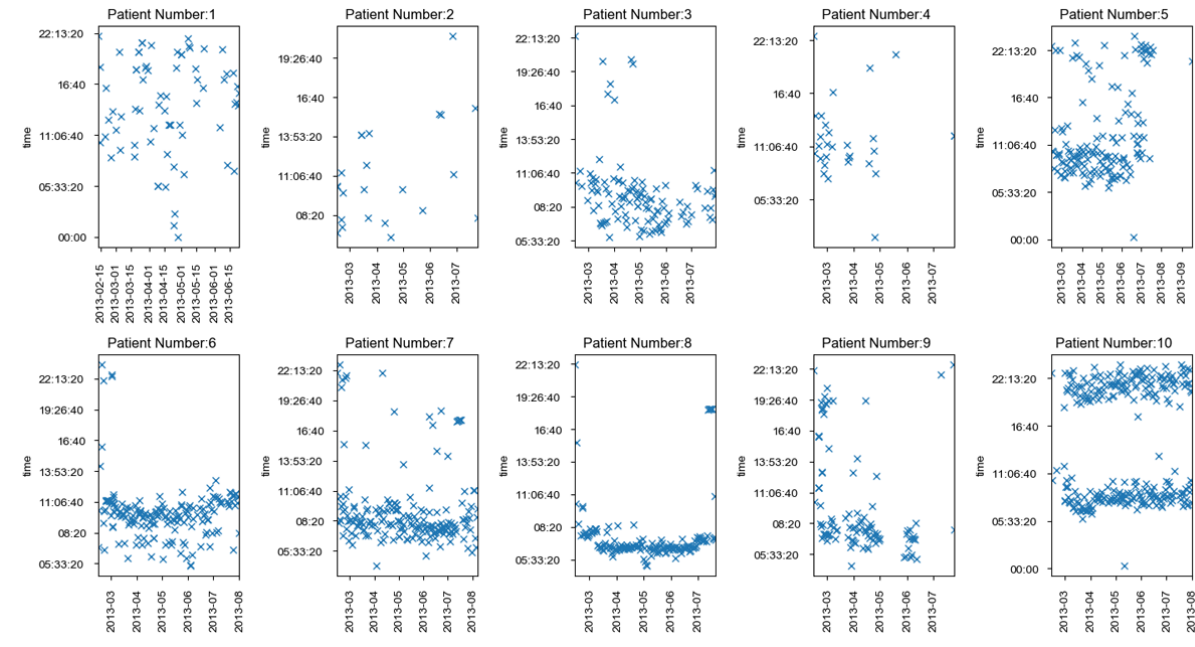
Figure 2. Time distribution of self-monitored blood glucose level collection by the patients over the clinical trial. The x-axis represents the date and the y-axis represents the time of the day that data has been collected. If the same date has two recorded times, that means the patient has collected their blood glucose twice in the same